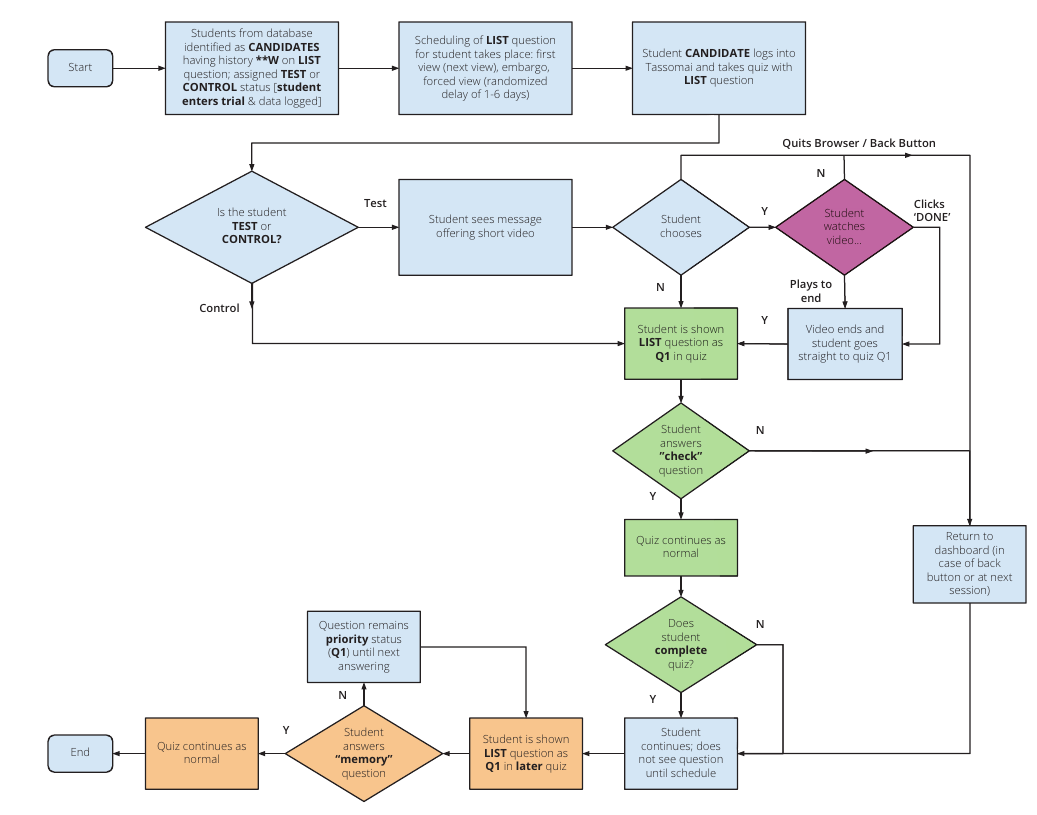
figure 2: experimental design brief setting out caNDIDaTe selection and user flows through the quizzing process (source: